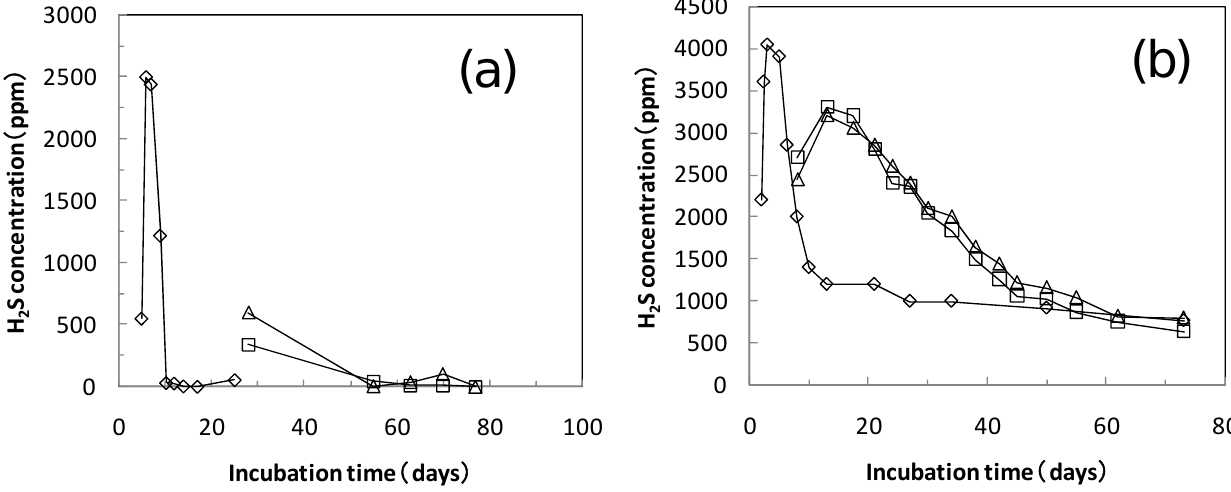
Figure 7. H S concentration in PLA anaerobic biodegradation test. The test vessels were 2 incubated at 35  C (a) and 55  C (b). ◊ ; cellulose 10g, ∆ , □ ; PLA